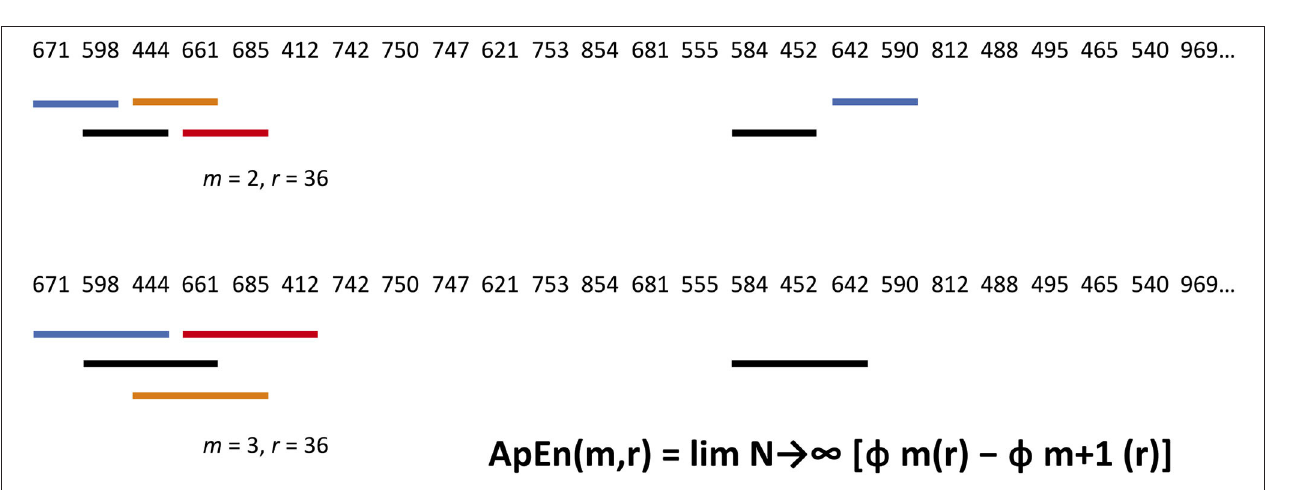
Yet information and energy have links that go well